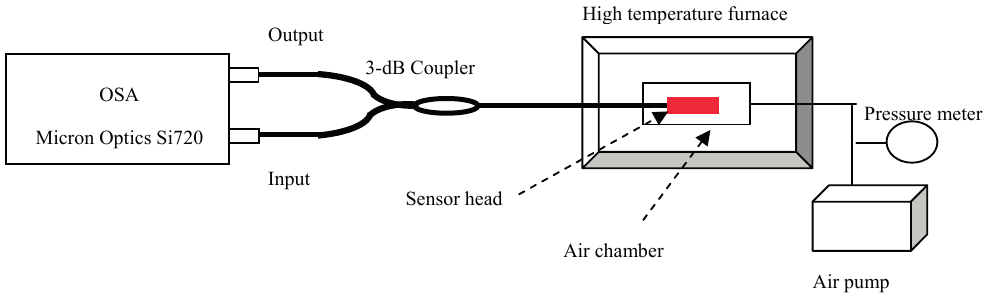
Figure 4. Experimental setup for high-temperature and high-pressure test.